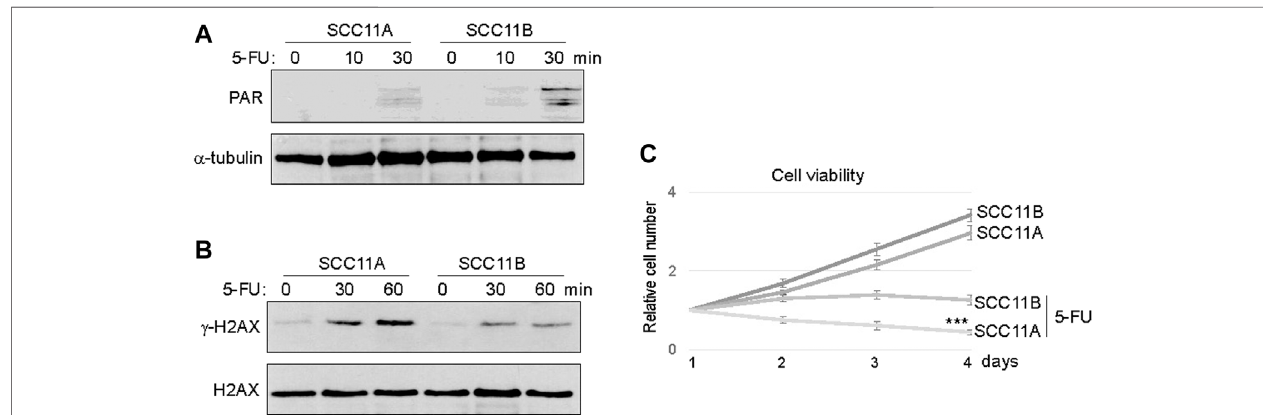
FIGURE3| SCC11BcellsexhibitedincreasedPARylationandcellresistance. (A) SCC11AandSCC11Bcellswereincubatedin5-FU(10 μ M),for10or30 min,as indicated.Cellswereharvestedforimmunoblotting. (B) SCC11AandSCC11Bcellswereincubatedin5-FU(10 μ M),for30or60 min,asindicated.Cellswereharvested for immunoblotting. (C) Cell viability assay was performed as in the Materials and Methods. SCC11A and SCC11B cells were incubated for 4 days. 5-FU (10 μ M) was added at day 1. The cell numbers at days 2 – 4 were normalized to that at day 1 (untreated). The mean values and standard derivations, from three independent experiments, were shown.